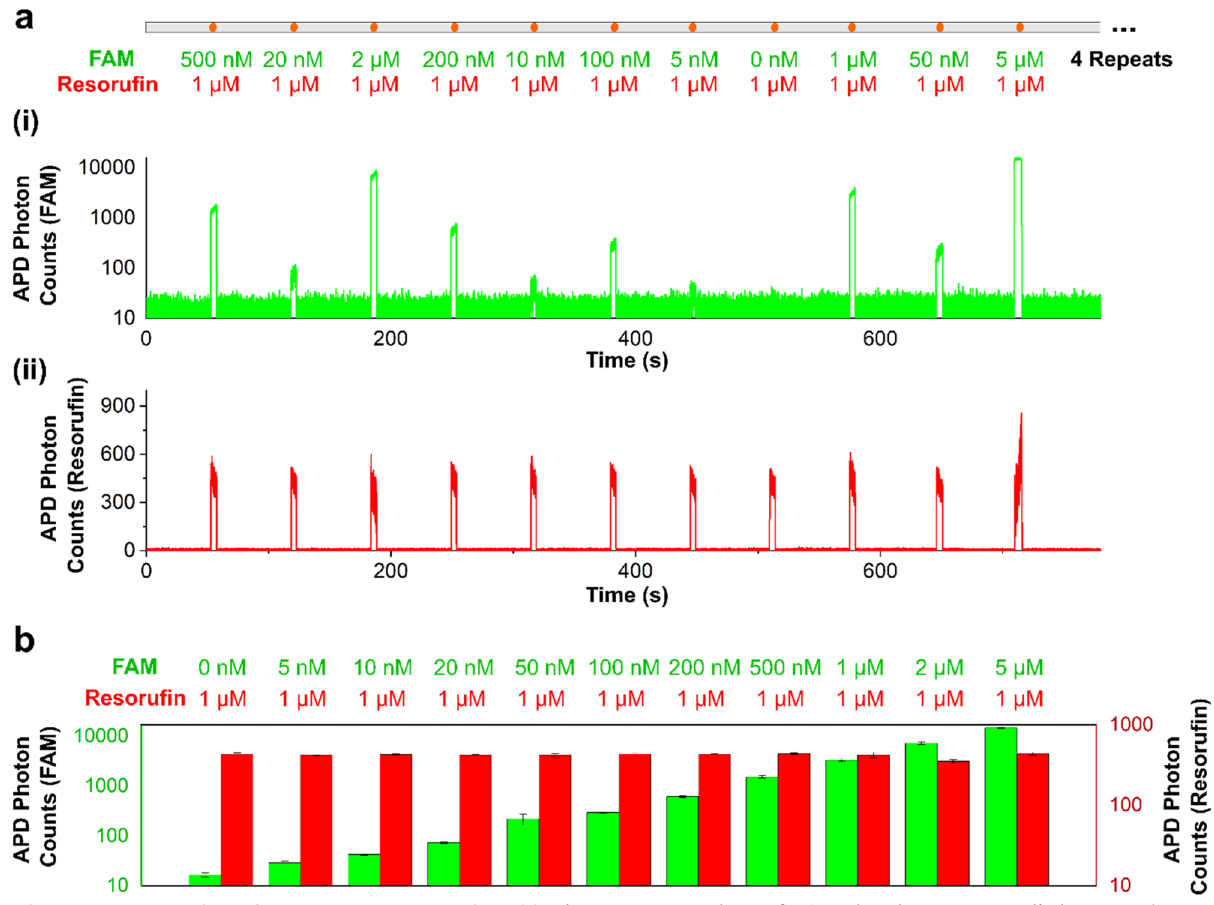
Figure 5. Demonstration of scalable sample loading. ( a ) Eleven concentrations of FAM dye that represent distinct samples are loaded in a scrambled sequence through dual TESLIs into the integrated droplet device and assembled with resorufin at 1:1 ratio to generate distinct droplets. To emphasize on sample loading and switching, only one droplet is generated per FAM sample. The sequence of the droplets based on their FAM final concentrations is 500 nM, 20 nM, 1 µM, 200 nM, 10 nM, 100 nM, 5 nM, 0 nM (i.e., water), 1 µM, 50 nM, and 5 µM, and all droplets contain 1 µM resorufin. The droplets are briefly incubated in the device and fluorescently detected by the custom LIF detector, which uses avalanche photodiodes (APDs) to quantify photons in the droplets. ( a ( i )) The APD photon counts in the FAM detection channel for the 11 droplets increase and decrease in accordance with the FAM concentration of the scrambled loading sequence, while ( a ( ii )) the APD photon counts in the resorufin channel for all 11 droplets are uniform (after subtracting crosstalk fluorescence signal from FAM), consistent with the uniform resorufin concentration. ( b ) The same 11 concentrations of FAM dye are repeated 4 times in the same scrambled order, and we obtained comparable results among them. The error bars depict ± 1 standard